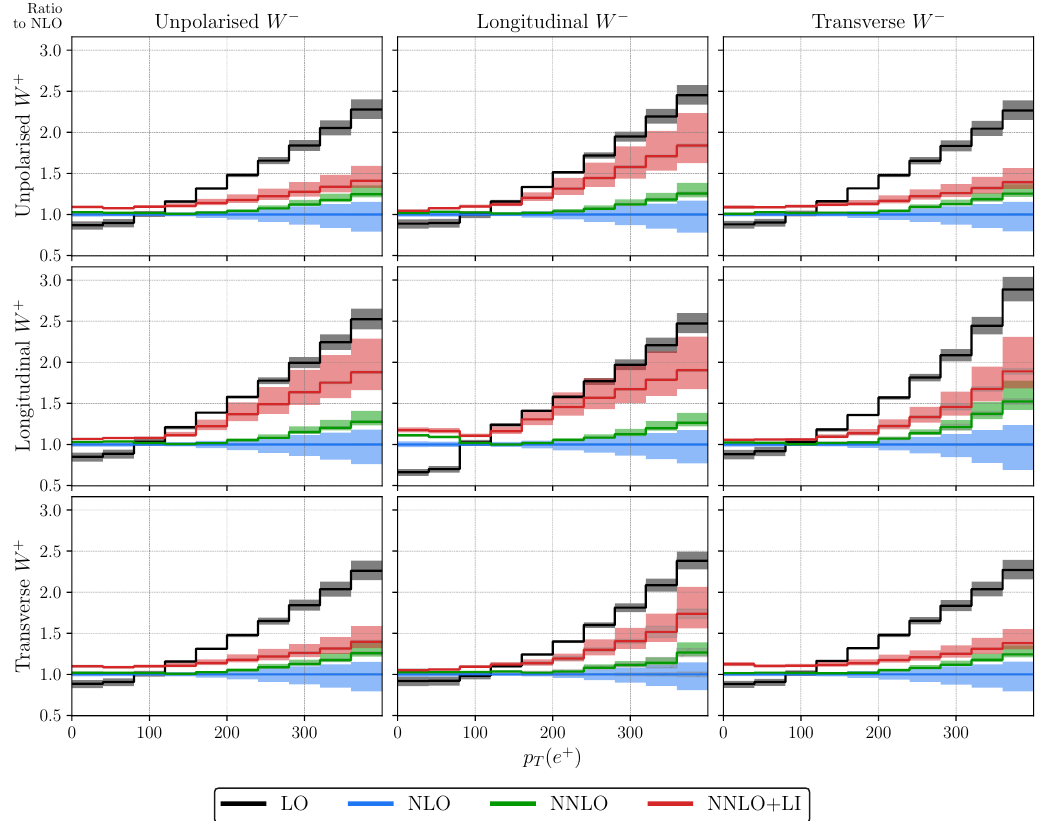
Figure 6 . Ratio to NLO of e + transverse momentum distribution at various orders of perturbative QCD. Each of 9 panes represents a selected polarisation setup calculated within DPA frame- work. W + and W − polarisation setups { U, L, T } are cycled across vertical and horizontal plots respectively. Coloured regions represent scale variation bands, and grey bands — Monte-Carlo